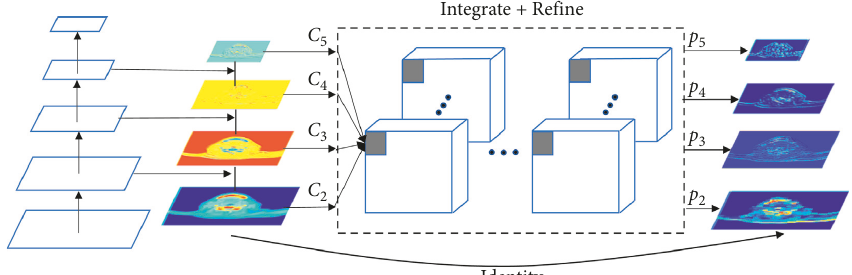
Figure 1: Visualization of balanced feature